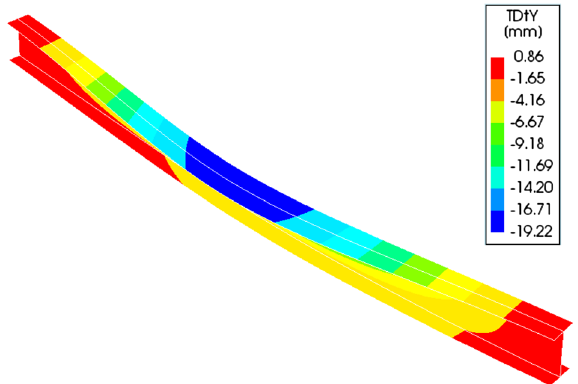
Fig. 13 Lateral displacement of the beam at the vertical load of 393 N obtained from the nonlinear analysis in DIANA (2016).